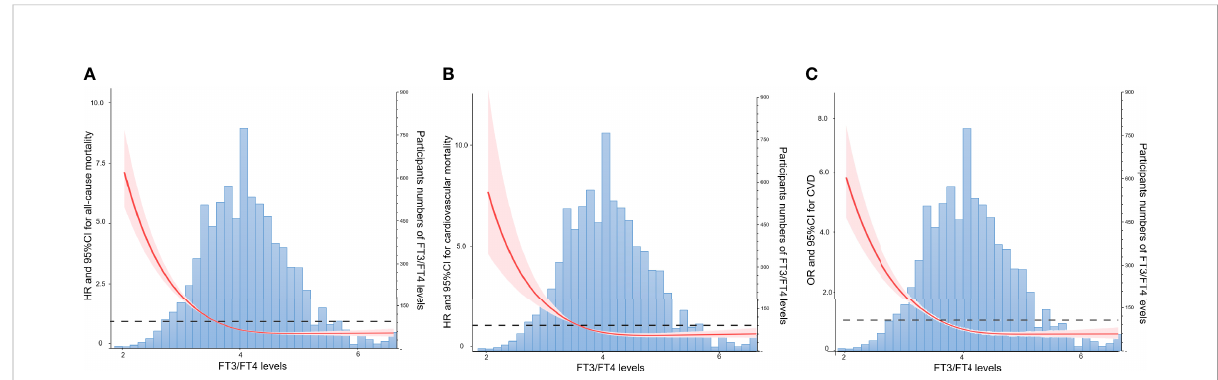
FIGURE 2 Association of the FT3/FT4 Ratio with All-cause Mortality, Cardiovascular Mortality, and CVD Risk by Unadjusted Restricted Cubic Splines. (A) Association of the FT3/FT4 Ratio with All-cause Mortality. (B) Association of the FT3/FT4 Ratio with Cardiovascular Mortality. (C) Association of the FT3/FT4 Ratio with CVD Risk.FT3, free triiodothyronine; FT4, free thyroxine.